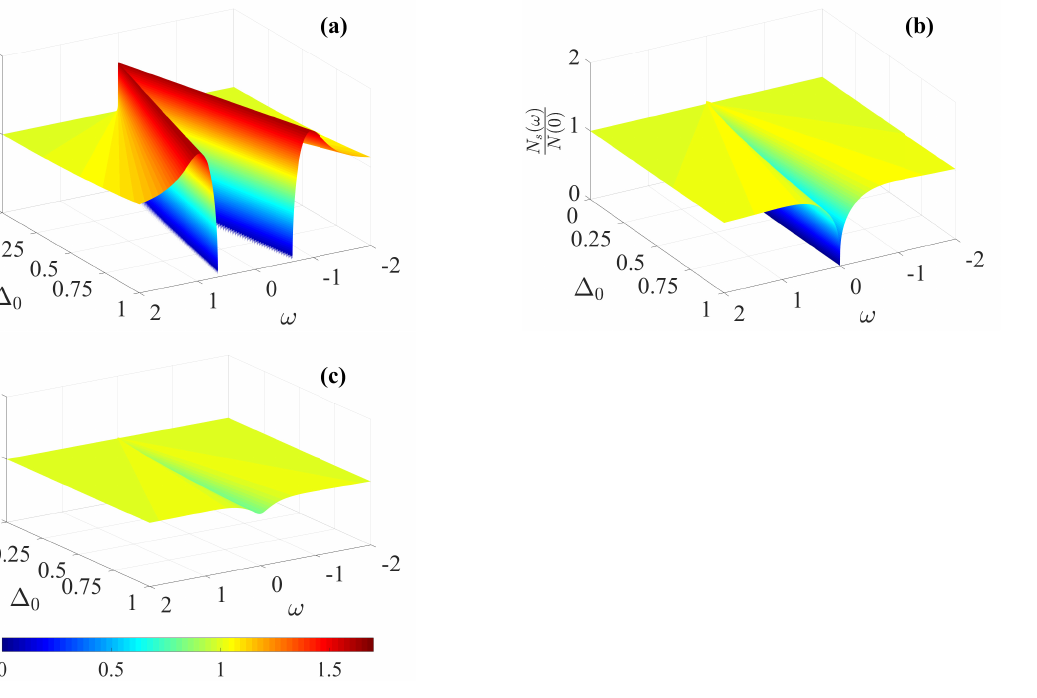
space from the gap state with ζ = 0.1 (a), 0 are used in the 0